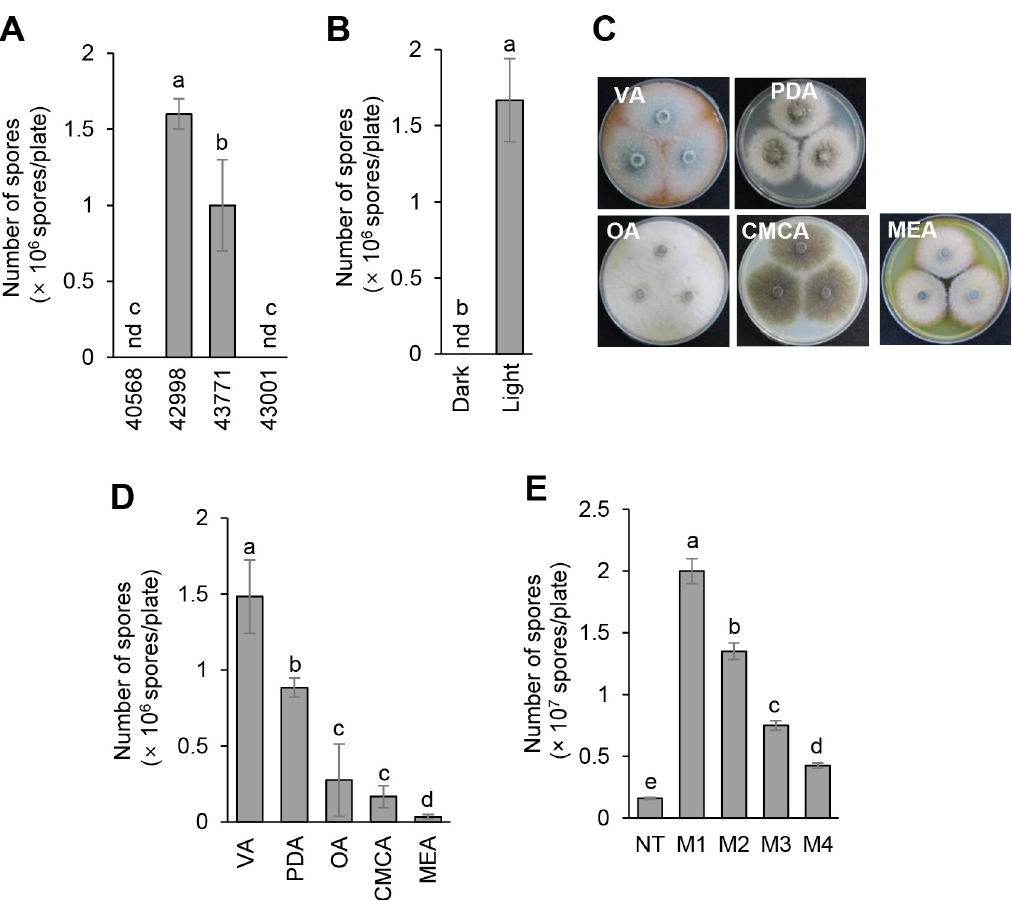
Fig 1. Spore production of Alternaria porri . (A) Comparison of spore production of four A . porri isolates grown on V8 medium for 9 days. (B) Effects of light on spore production of A . porri KACC 42998. (C and D) Spore production of A . porri KACC 42998 grown on different media for 9 days. V8, V8 juice agar medium; PDA, potato dextrose agar medium; OA, oatmeal agar medium; CMCA, carboxymethyl cellulose agar medium; MEA, malt extract agar. Photos of the culture plates were taken at 7 dpi. (E) Effects of physical stress on spore production. The culture surface of the V8 medium was not damaged mechanically (NT), scraped by a blade (M1) and brush (M2), or scratched into grid patterns with 2-mm (M3) and 5-mm (M4) spacing by a scalpel blade. The bars represent the mean ± standard deviation of two runs with three replicates. Different letters indicate significant differences at p < 0.05.